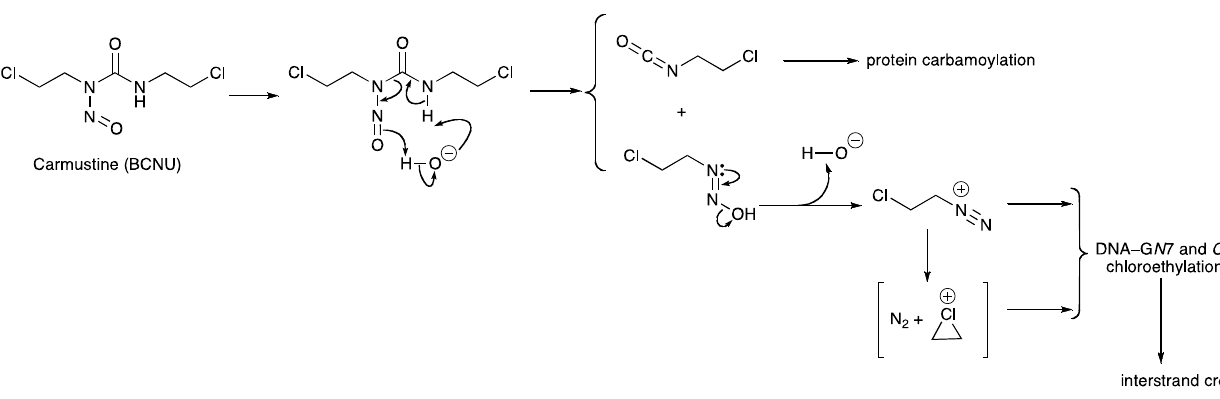
Scheme 3. Mechanism of prodrug activation and action of